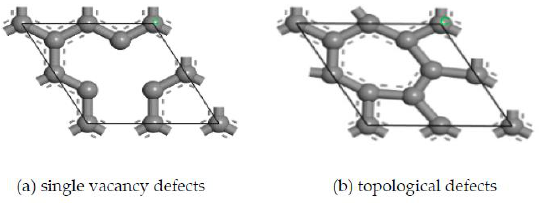
Figure 5. Defective graphene.